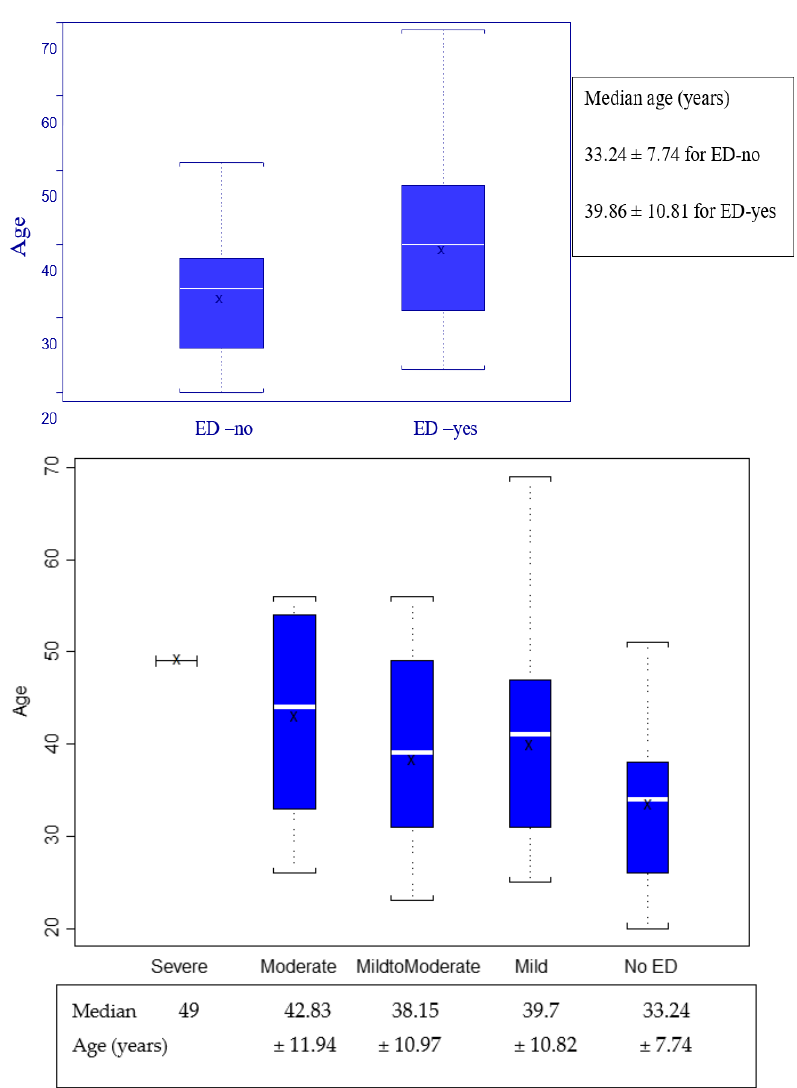
Figure 2. Age distribution related to erectile function.